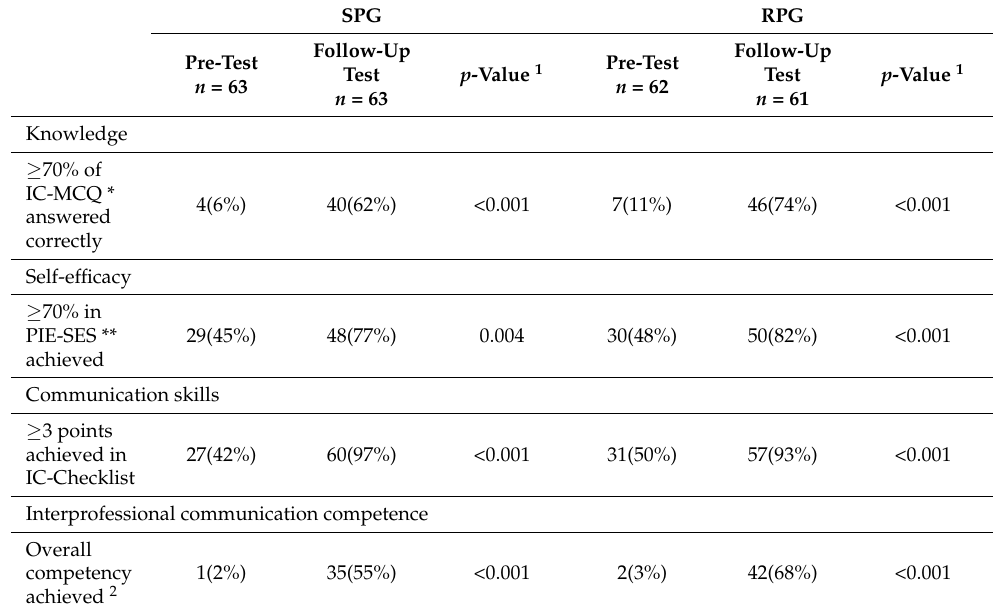
Table 5. Counts (proportions) of dichotomous interprofessional communication competency parame- ters per group for pre-test and follow-up